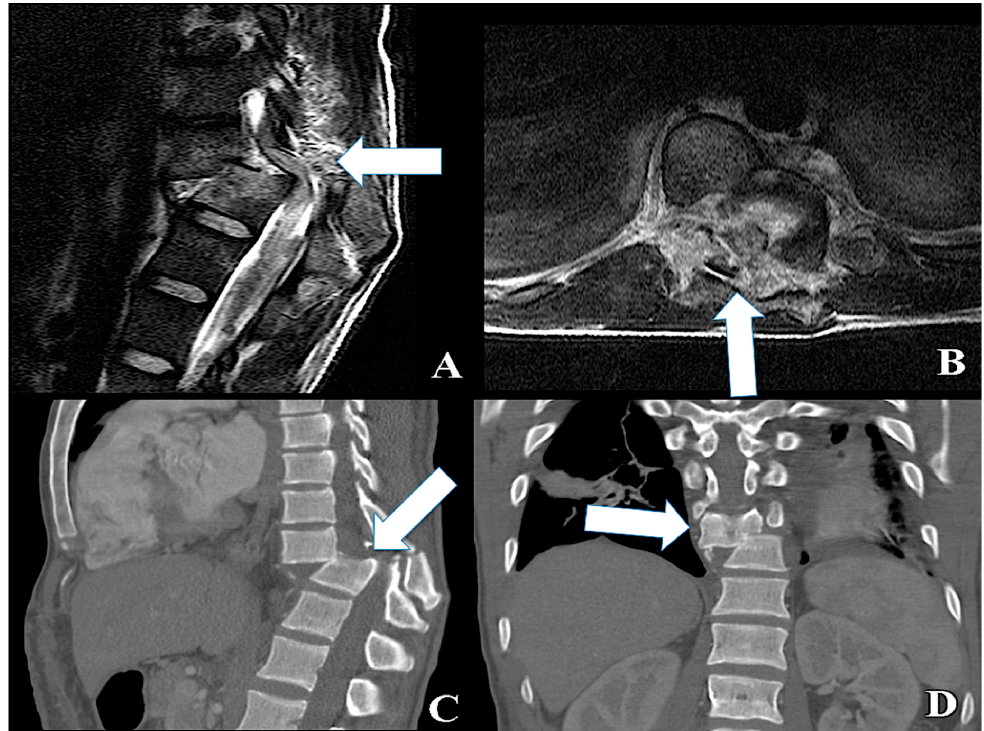
Figure 2. - In ( A ) and ( B ): a “C”-type Spine Fracture Dislocation with a complete Spinal Cord Injury (arrow). In ( C ) and ( D ): a CT scan of the spine disclosing a severe dislocation both on coronal and (arrow). In ( C ) and ( D ) : a CT scan of the spine disclosing a severe dislocation both on coronal and sagittal plane sagittal plane (arrow).